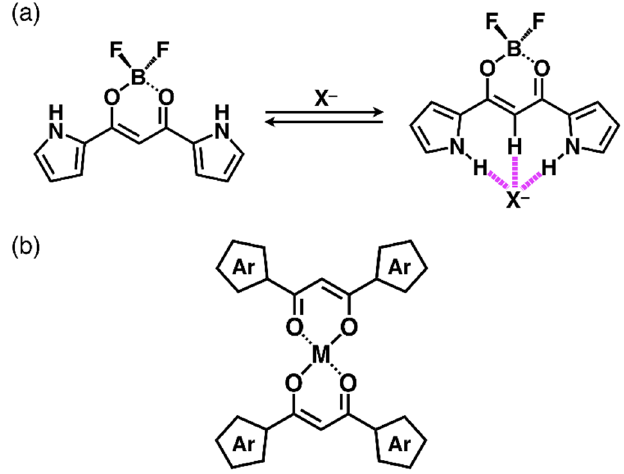
Figure 1. ( a ) Dipyrrolyldiketone BF 2 complex and its anion-binding mode and ( b ) 1,3-diketone divalent metal complexes.